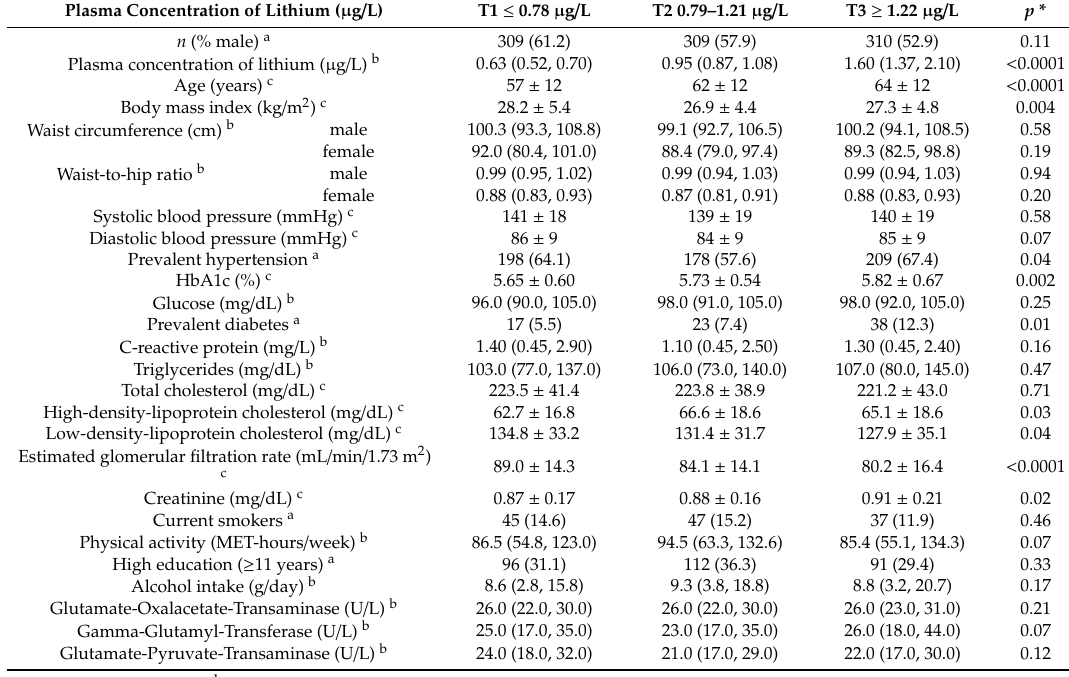
Table 2. General characteristics of the overall study sample according to tertiles of circulating plasma lithium concentrations ( n =